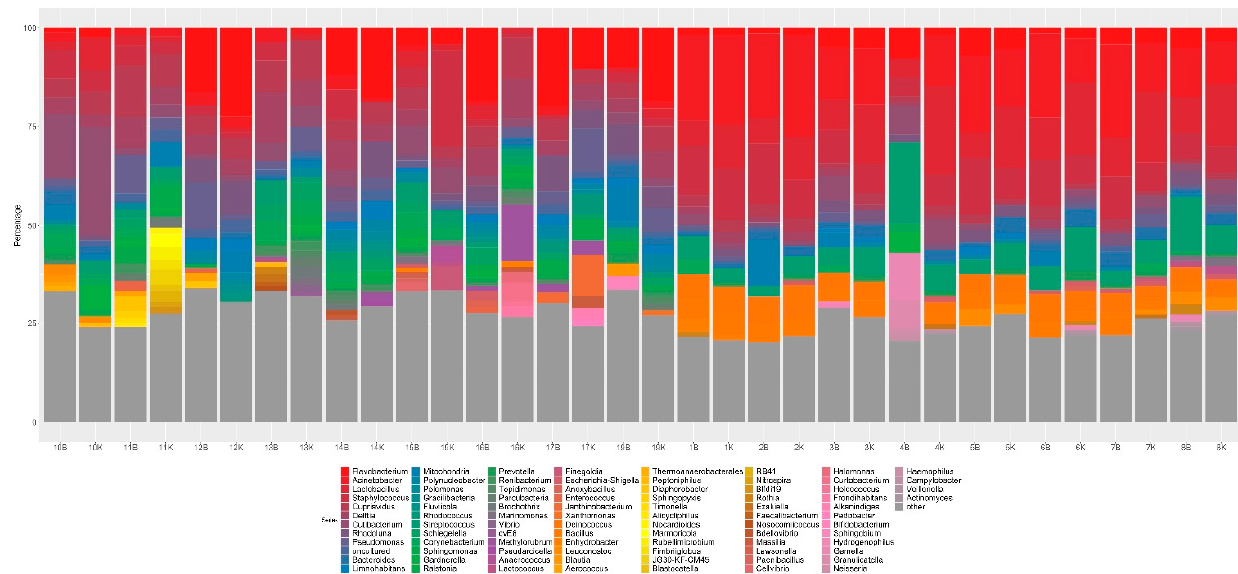
Figure 6. Genera of microbiomes isolated from bladder body (K) and trigonal (B) urothelium. Only the most abundant bacteria are shown.